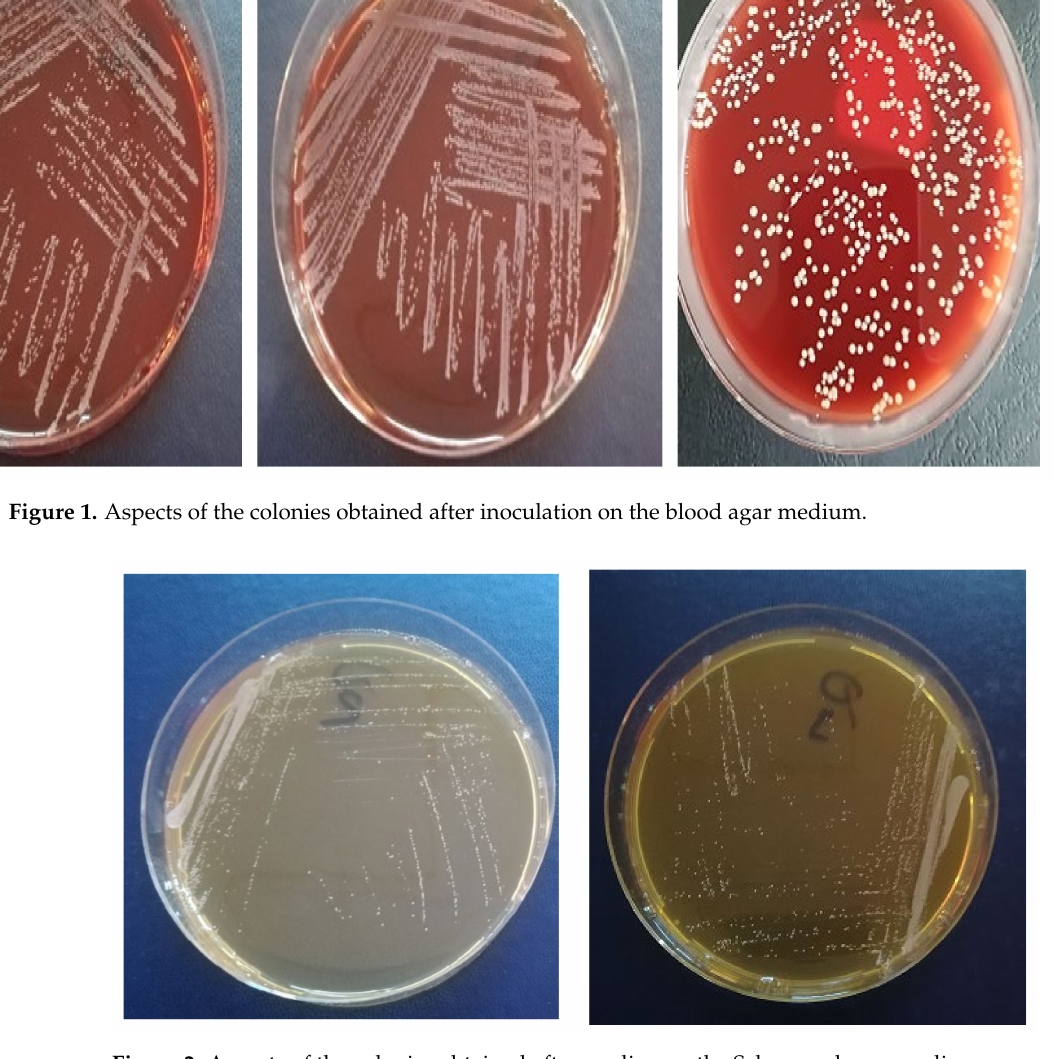
Figure 2. Aspects of the colonies obtained after seeding on the Sabouraud agar medium. The results showed that all the isolated strains were resistant to some beta-lactam antibiotics (penicillin and ceftaroline). The S. epidermidis strain, besides the resistance to beta-lactams, was also resistant to tetracycline and the tested macrolides (azithromycin and erythromycin) (Table 1, Figure 3). Table 1. Sensitivity pattern of the analyzed